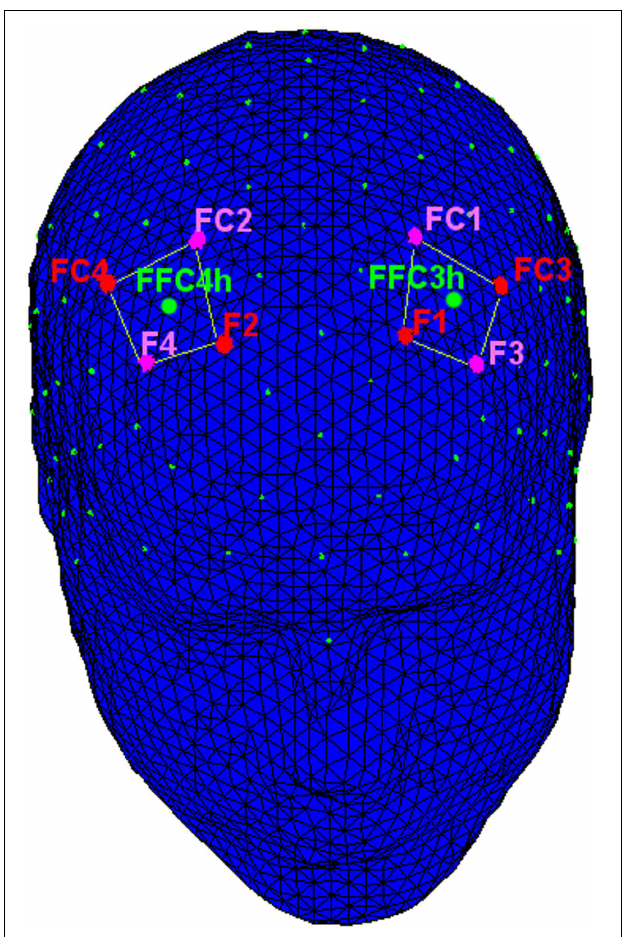
FIGURE 2 | The location of the measurement near-infrared spectroscopy (NIRS)/electroencephalographic (EEG) channels. NIRS: The emitters were placed on positions FC3–FC4 and F1–F2 (red dots), while detectors were placed on FC1–FC2 and F3–F4 (pink dots). EEG: left and right frontal (green dots: FFC3h and FFC4h) alpha power activity was